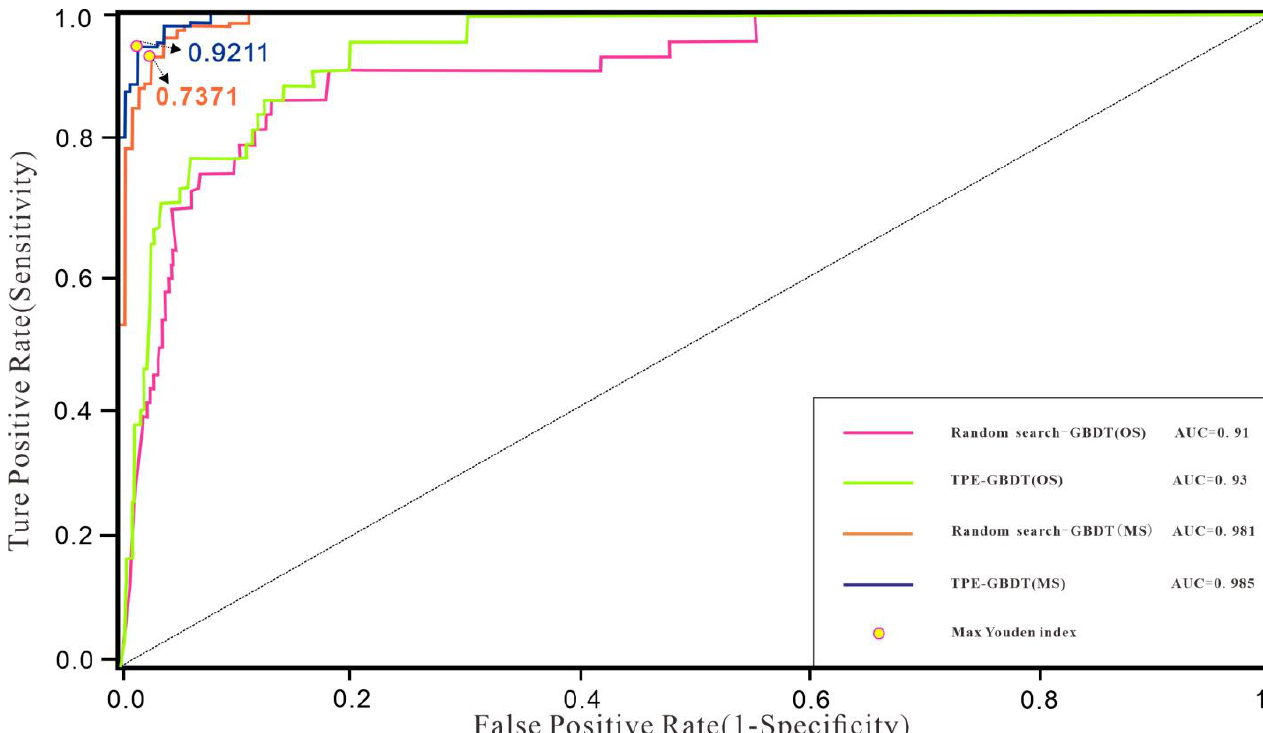
Figure 10. ROC curves of Random search-GBDT model and TPE-GBDT model.